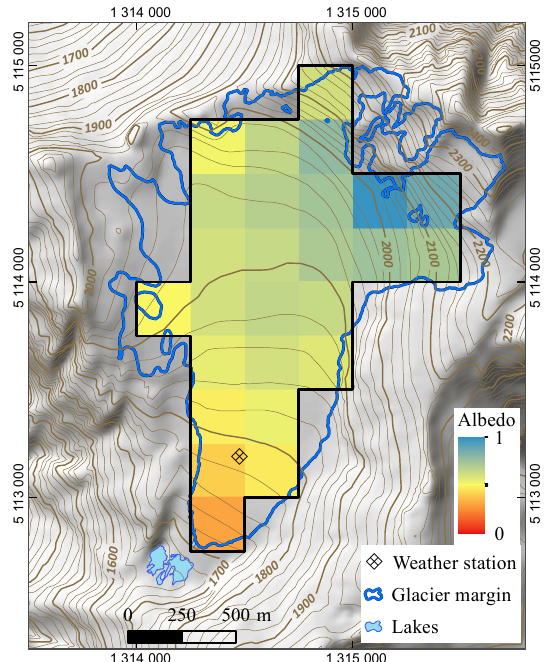
Figure 5. White-sky albedo of Brewster Glacier on 25 Febru- ary 2012, 10.45a.m. (NZST) retrieved with the snow/ice anisotropic reflectance